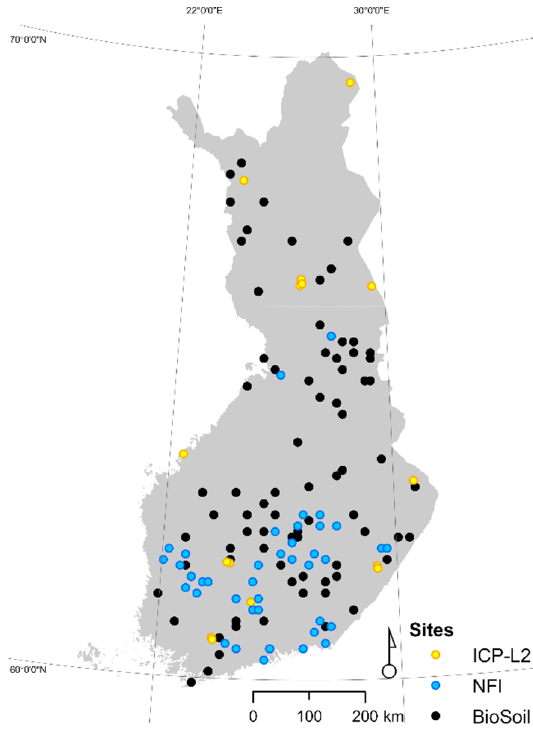
Figure 1. The location of the BioSoil sites (black), ICP-L2 plots (yellow) and additional NFI sites (blue).